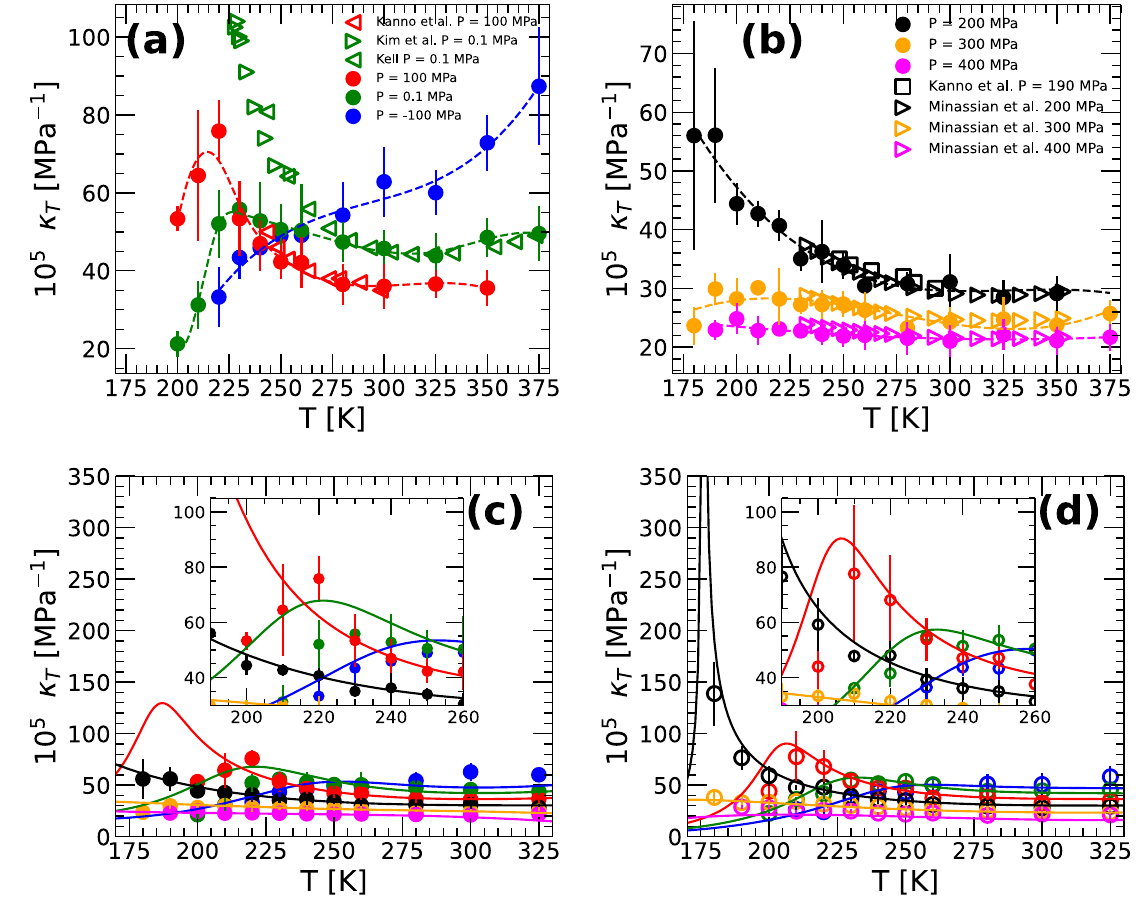
Figure 3. ( a ) Isothermal compressibility of q-TIP4P/F water from PIMD simulations at pressures P = − 100, 0.1, 100 MPa (solid circles; dashed lines are guides to the eye). Experimental data for κ T ( T ) are indicated by open symbols (red left-triangles, green left- and right-triangles are from Refs. 5,65,66 , respectively). ( b ) Same as ( a ) for pressures P = 200, 300, 400 MPa; experimental values of κ T ( T ) are from Refs. 65,67 . ( c ) Comparison between the values of κ T ( T ) obtained from the PIMD simulations [solid circles; from ( a ) and ( b )] and the TSEOS (solid lines). ( d ) Comparison between the values of κ T ( T ) obtained from the MD simulations (empty circles) and the TSEOS (solid lines). Insets are magnifications of the main panels. The predictions of the TSEOS are in very good agreement with the MD simulation results and semiquantitative agreement in the case of PIMD